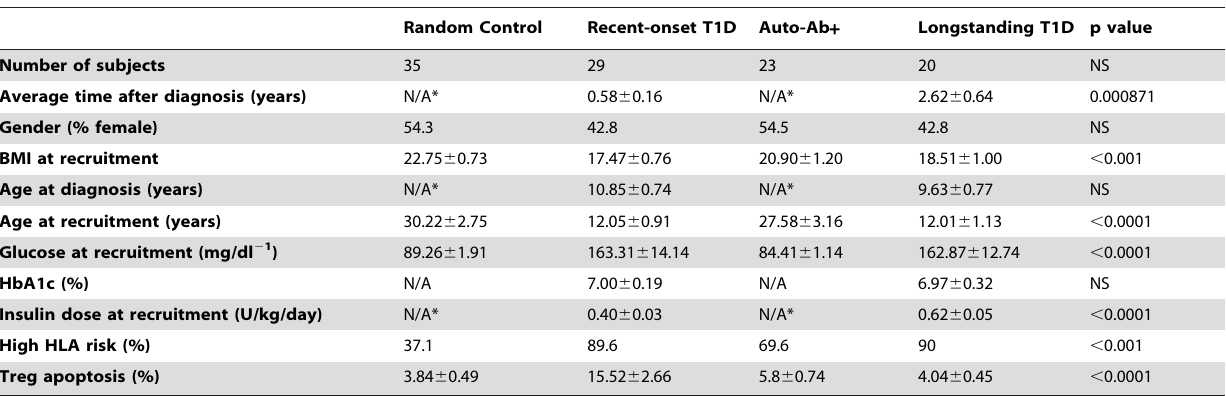
Table 1. Demographic data of studied